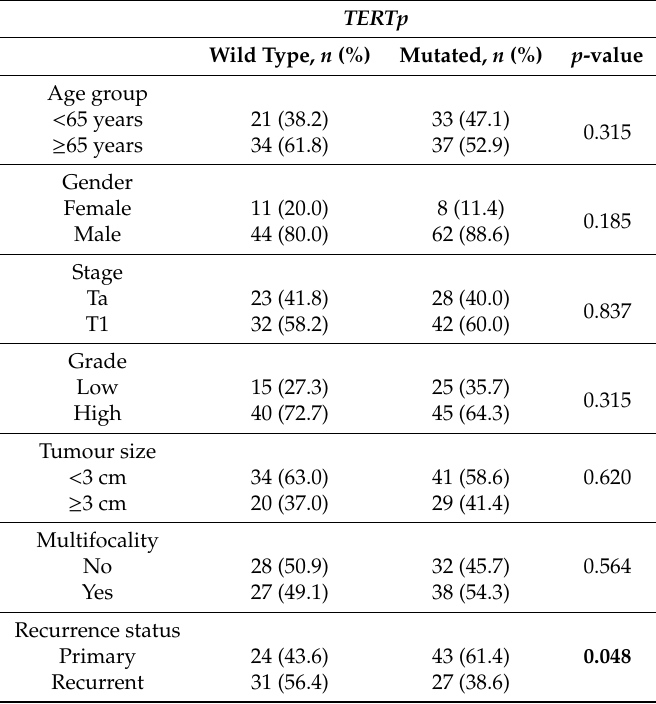
Table 2. Relation between clinicopathological data and TERTp mutation status in BCG-NMIBC.